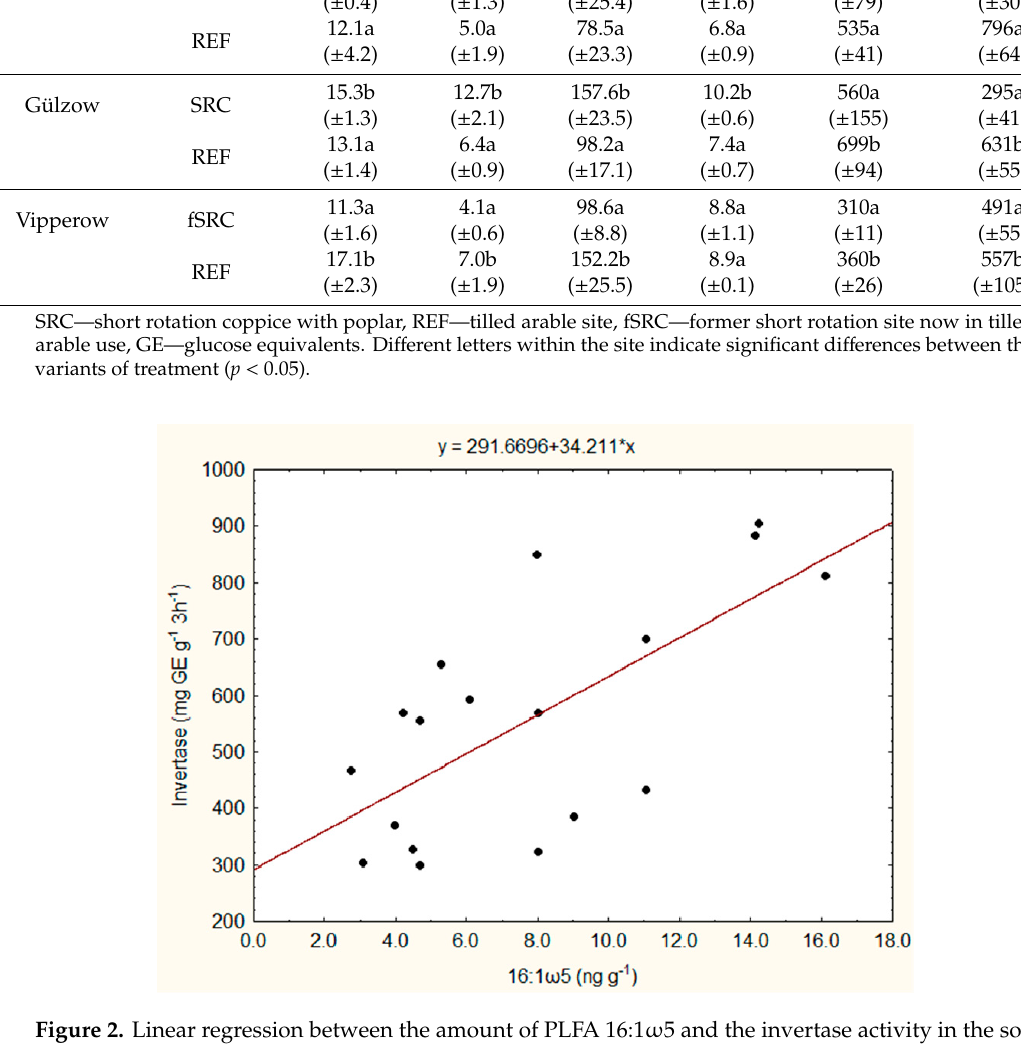
Figure 2. Linear regression between the amount of PLFA 16:1 ω 5 and the invertase activity in the soil (0–5 cm depth) of test sites with two managements: under short rotation coppice (SRC) or former short rotation coppice (fSRC) and reference sites with cereals or grassland (REF) (three test sites with n = 6 test plots each; 18 plots in total ( R 2 = 0.46, p < 0.05, n = 18).